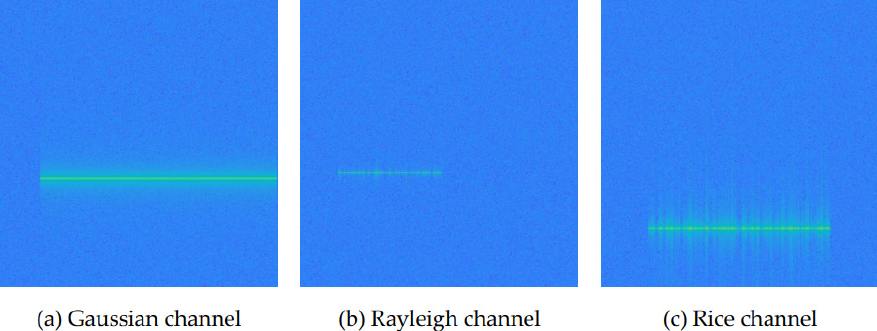
Figure 6. Time frequency diagram of single frequency interference in different channels, SNR = 10 dB. ( a ) Gaussian channel, ( b ) Rayleigh channel, ( c ) Rice channel.